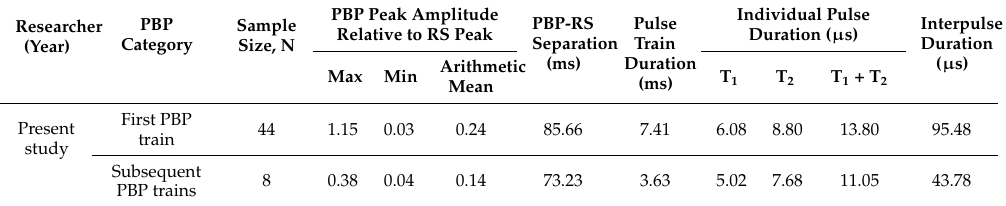
Table 6. Comparison on PBP characteristics between first and subsequent PBP